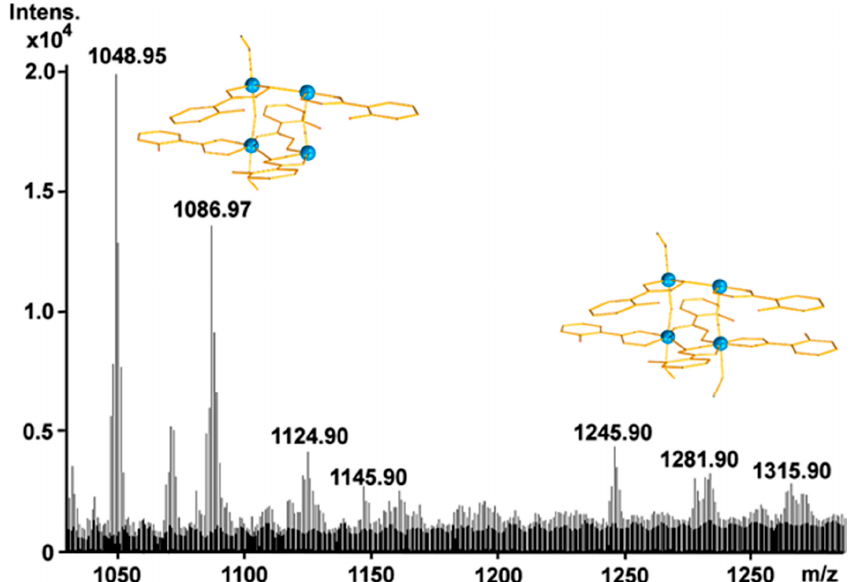
Figure 4. Negative mode of the high m / z region electrospray ionization mass spectrum (ESI-MS) of the {Ti 4 } ( 1 ) cluster in CH 3 OH. Table 2. Representation of the experimentally identified and simulated m / z values of distribution patterns of {Ti 4 } cluster. Experimental